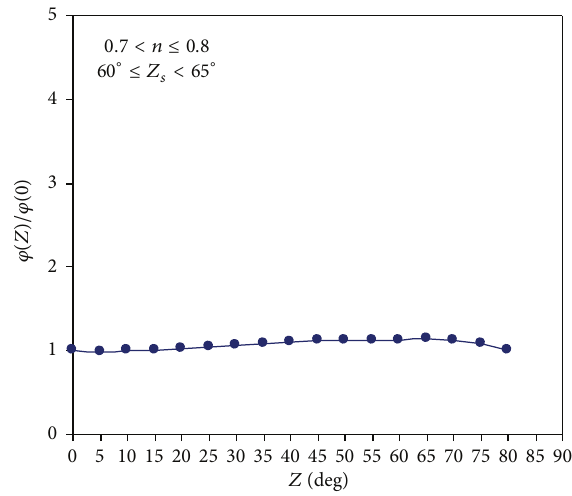
Figure6:Exampleoftheplotof 𝜑(𝑍)/𝜑(0) against 𝑍 forsolarzenith angle 60 ∘ ≤ 𝑍 𝑠 ≤ 65 ∘ and cloud index 0.7 ≤ 𝑛 ≤ 0.8 . 𝑍 is the zenith angle of the sky subzone.